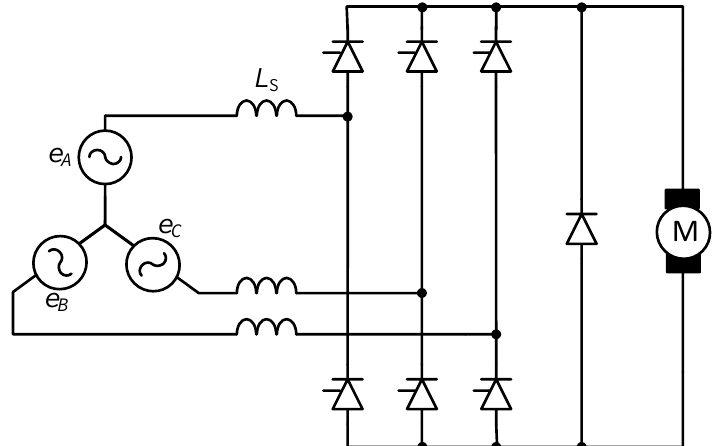
Figure 5. Main circuit structure.